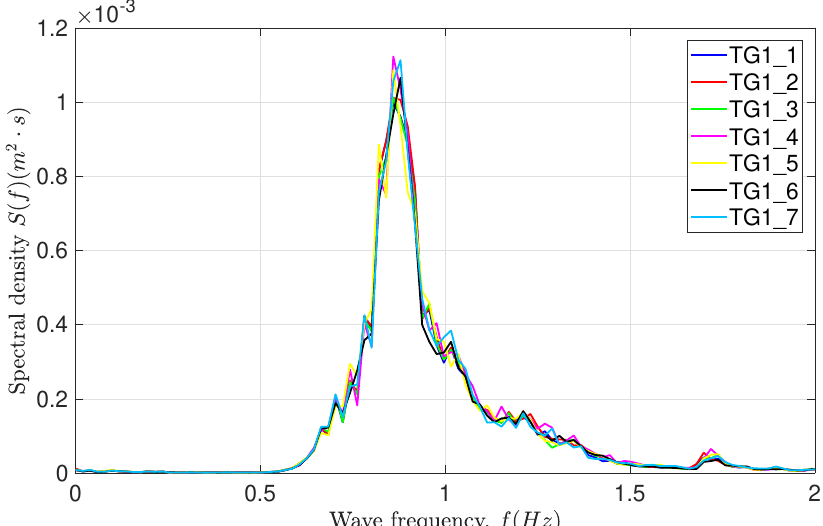
Figure 5. Measured wave spectra